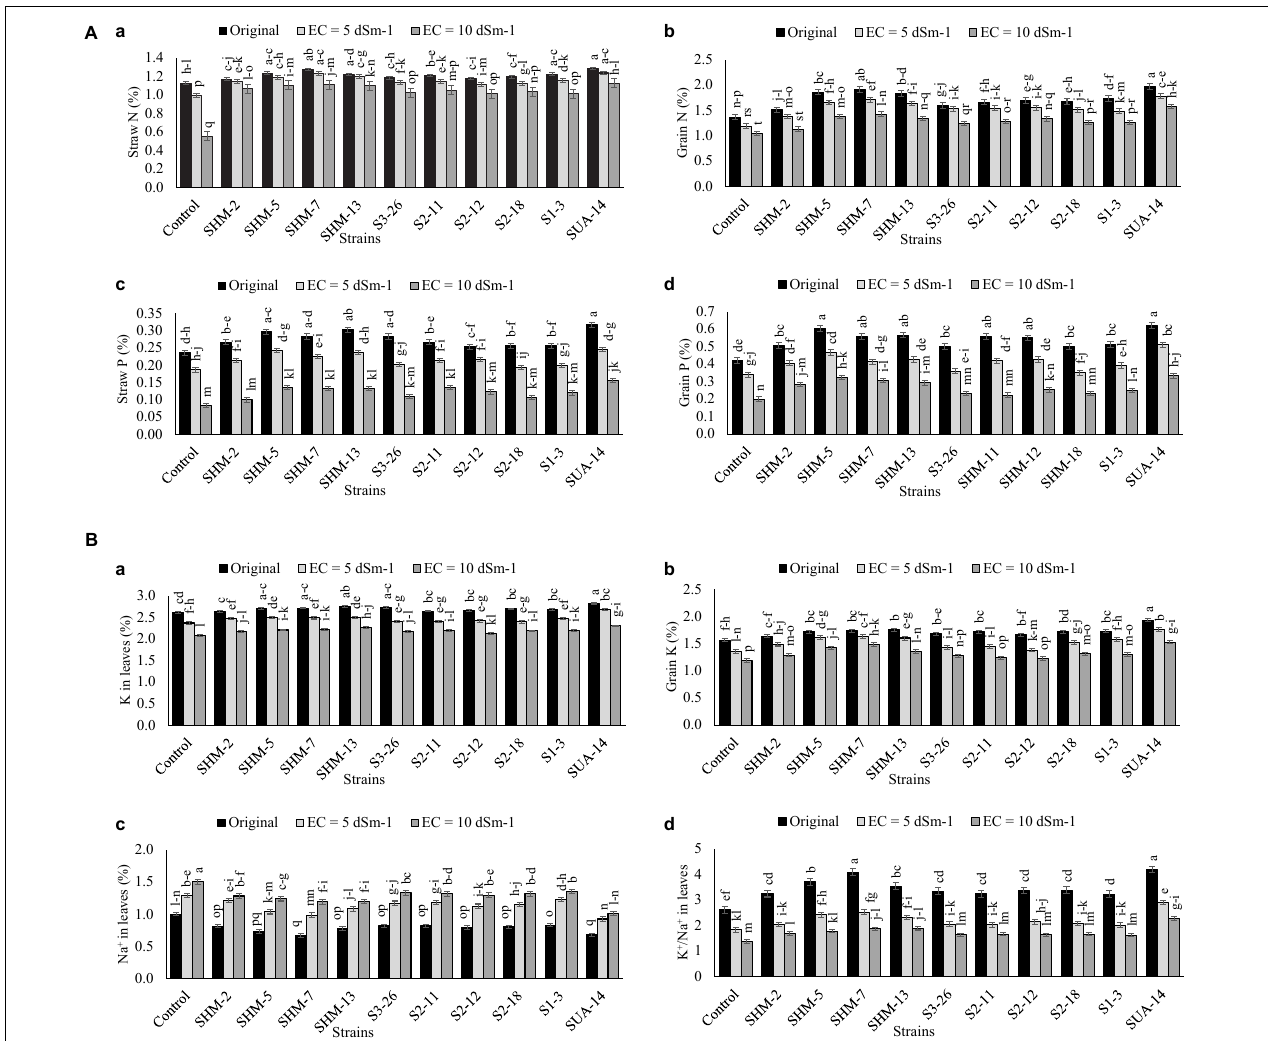
FIGURE 6 | (A) Effect of rhizobacterial inoculation on the nutrient uptake in different plant parts. (a) Straw N (%), (b) Grains N (%), (c) Straw P (%), and (d) Grains P (%) of maize under salt-stressed pot conditions. Bars sharing the same letters are statistically non-significant at p ≤ 0.05. (B) Effect of rhizobacterial inoculation on the nutrient uptake in different plant parts. (a) K in leaves (%), (b) Grains K (%), (c) Na in leaves (%) of maize, and (d) K + /Na + ratio in maize leaves under salt-stressed pot conditions. Bars sharing the same letters are statistically non-significant at p ≤